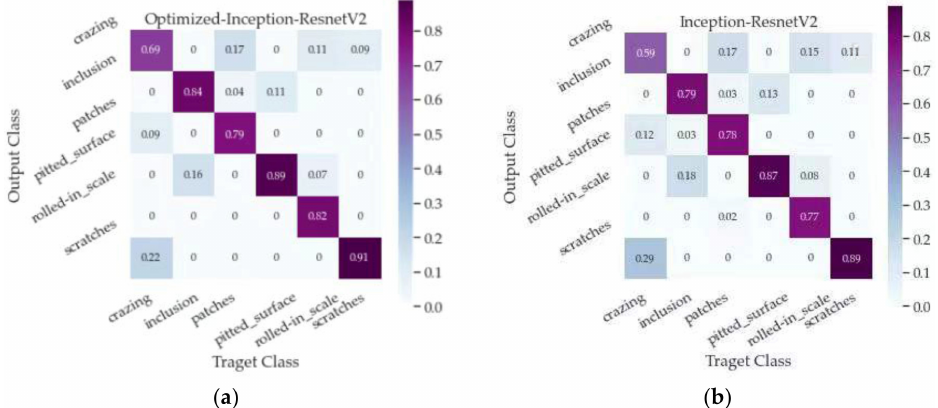
Figure 15. Confusion matrix of the Optimized-Inception-ResnetV2 and Inception-ResnetV2 models. ( a ) Optimized-Inception-ResnetV2. ( b )